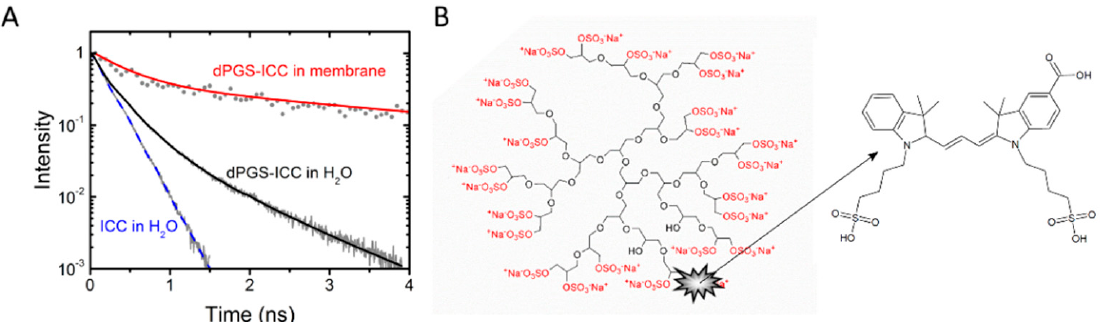
Figure 1. Structure and fluorescence lifetime characteristics of dPGS-ICC. ( A ) Fluorescence lifetime curves of ICC and dPGS-ICC in water and bound to DMPC lipid membranes; and ( B ) structural scheme of dPGS and the bound fluorescent tag ICC. A detailed description of the conjugation procedure is given by Licha et al. [13].